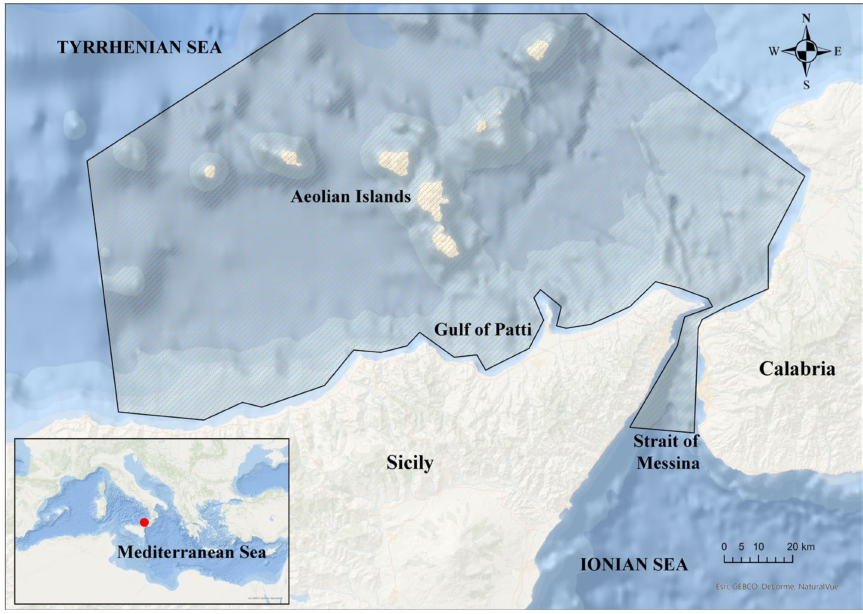
Figure 1. Study area including the southern Tyrrhenian Sea and the Strait of Messina. The delimited grey area indicates the study